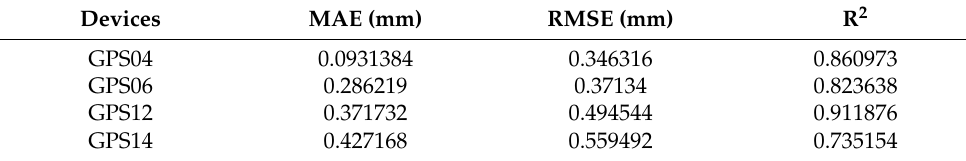
Table 5. Evaluation of the predictive ability of the DeepAR model for four GPS devices.